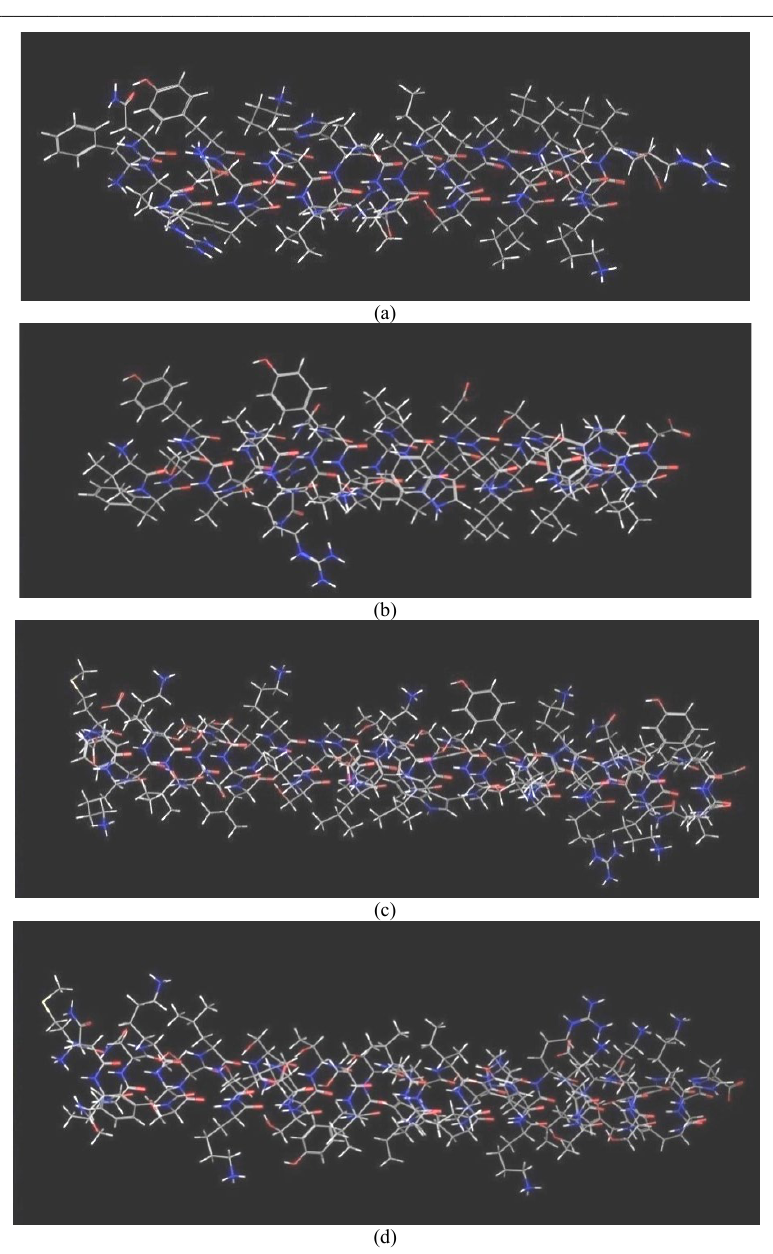
Fig. 2. Structure of a) plantaricin E; b) plantaricin F; c) plantaricin NC8α ; d) plantaricin